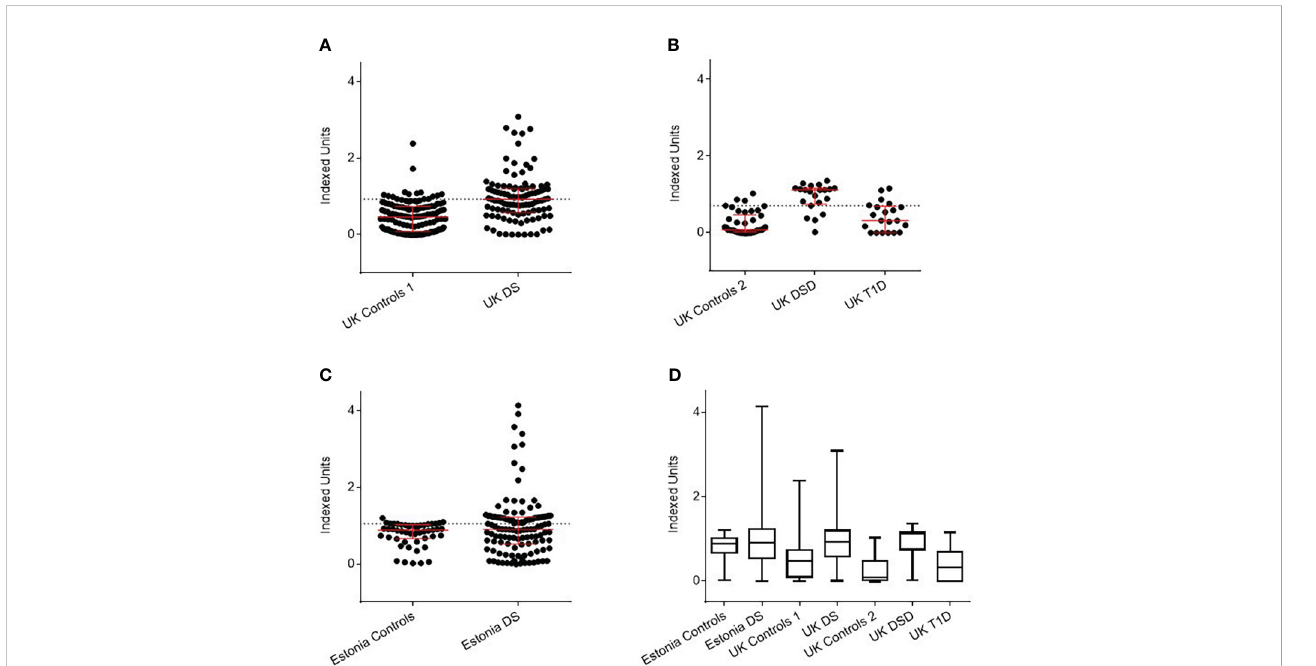
FIGURE 2 Detection of anti-BSA antibodies by DELFIA assay in Down Syndrome (DS) populations with age, sex, and nationality matched controls. (A) UK DS have increased levels of anti-BSA antibodies compared to controls (p<0.0001). (B) UK DSD with T1D have increased levels of anti-BSA antibodies compared to controls (p<0.0001), those with T1D alone have similar levels of anti-BSA antibodies compared to controls. (C) Estonian DS have similar median levels of anti-BSA antibodies compared to controls but 19 individuals with DS had elevated levels of anti-BSA antibodies. (D) Comparison of anti-BSA antibody titres detected by DELFIA assay between all cohorts. The dotted line represents the 90 th centile of age, sex, and nationality matched controls. The red bar represents median and interquartile ranges. Whiskers indicate minimum to maximum. Indexed units were calculated by subtracting the fl uorescence of the negative control and dividing by the cpm of the positive control minus the negative control. DSD, Patients with Down syndrome and T1D, Type 1